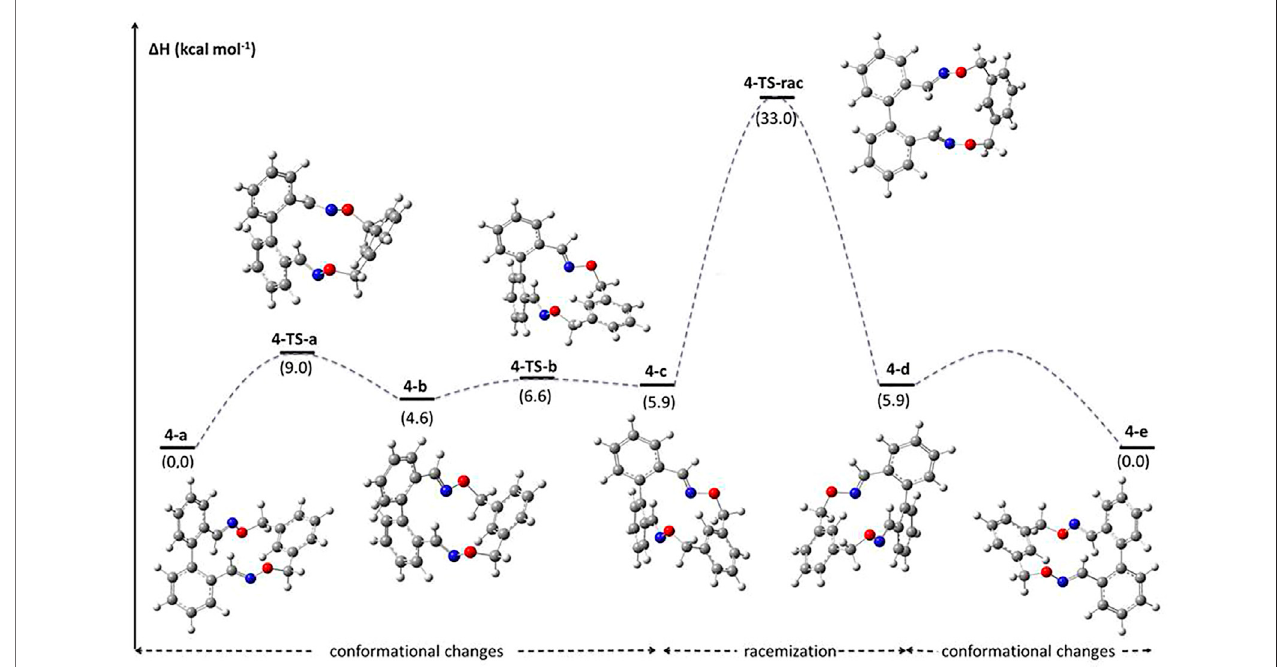
FIGURE6 | Calculated relative enthalpiesand barrier values (393 K, 1 atm) for theconformersand theTSs involved inthe racemizationmechanism ofderivative 4.